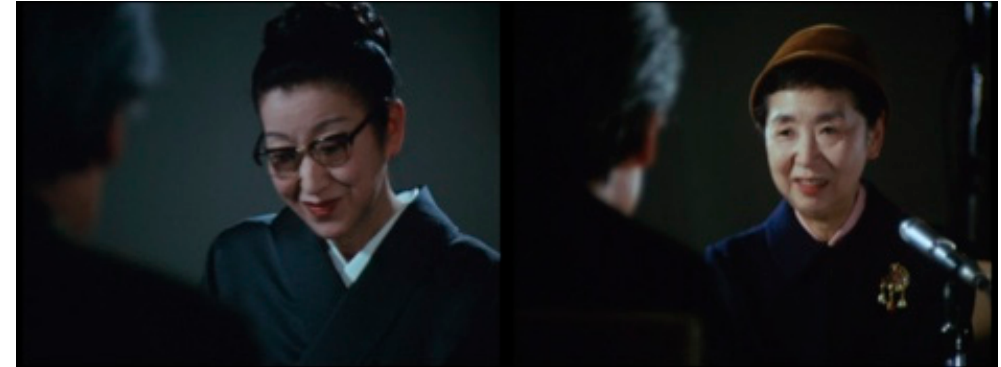
Figure 9. Kenji Mizoguchi: The Life of a Film Director (Shind ō Kaneto, 1975).